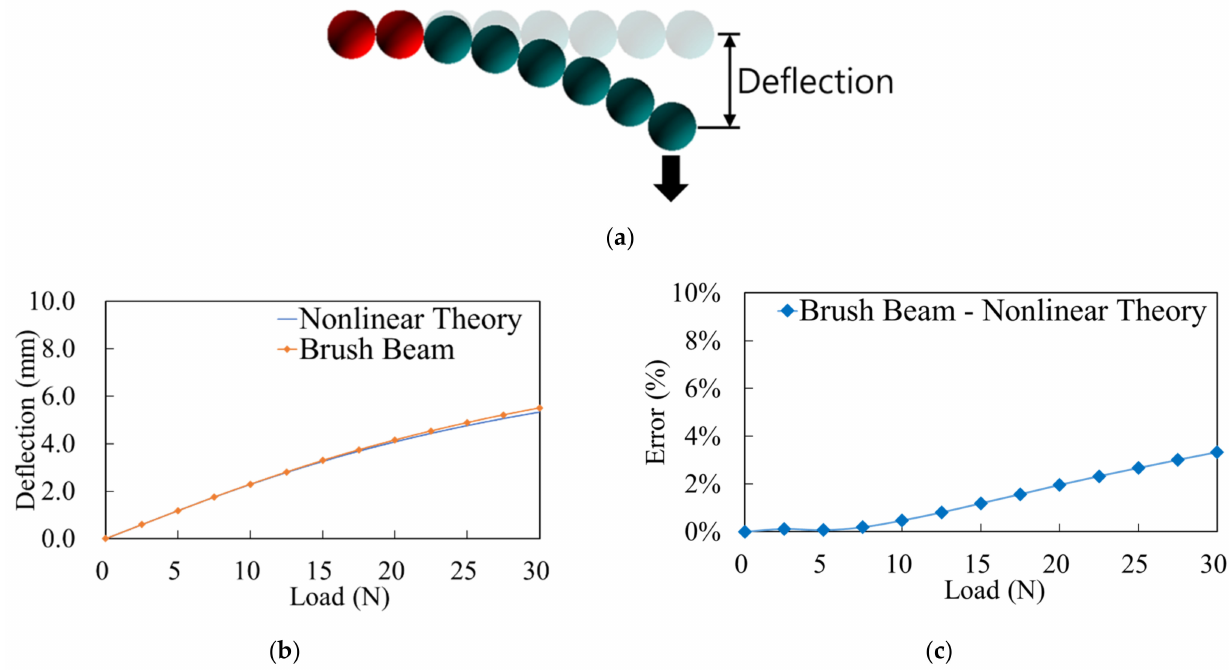
Figure 5. Comparison between nonlinear theory and discrete element method (DEM) results; ( a ) can- tilever beam deflection represented by the WLC model; ( b ) deflection; ( c ) estimated